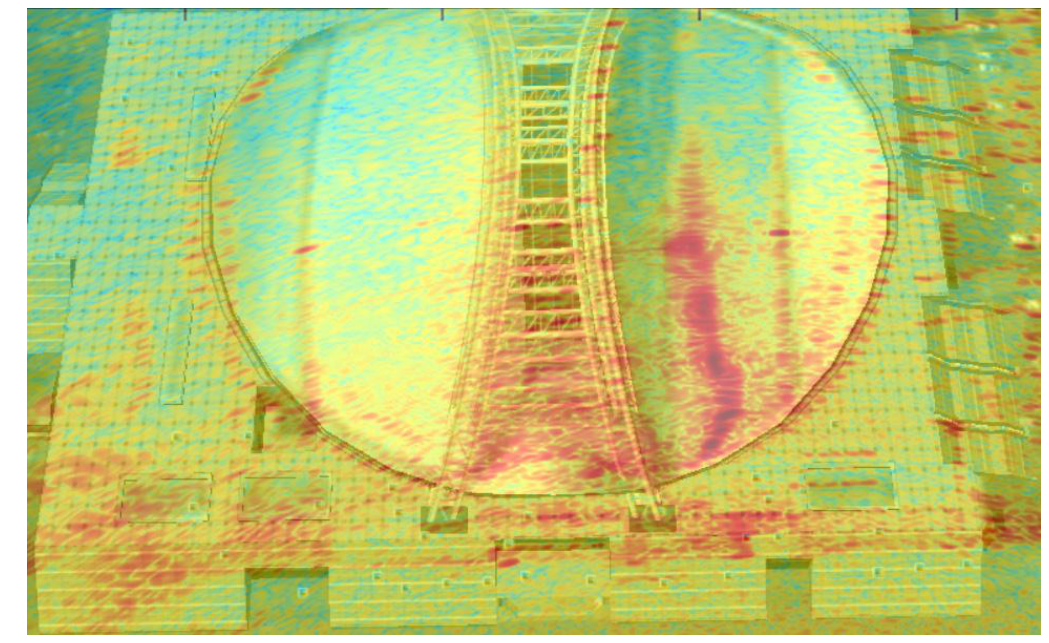
Figure 21. Comparison of optical picture and radar image.